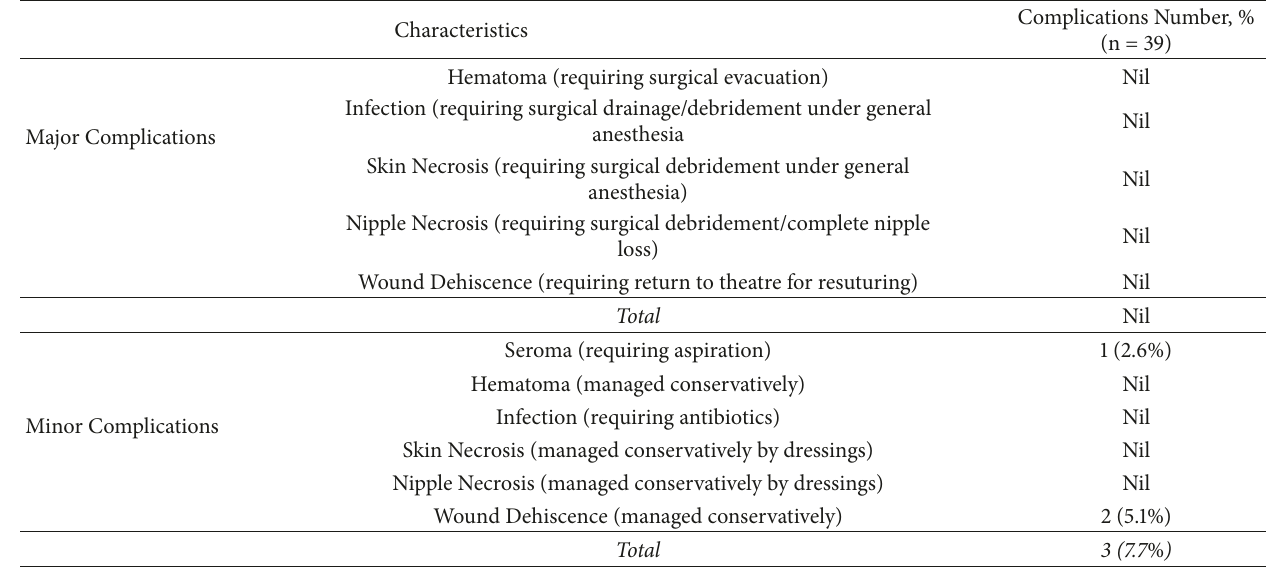
Table 3: Summary of postoperative complications.